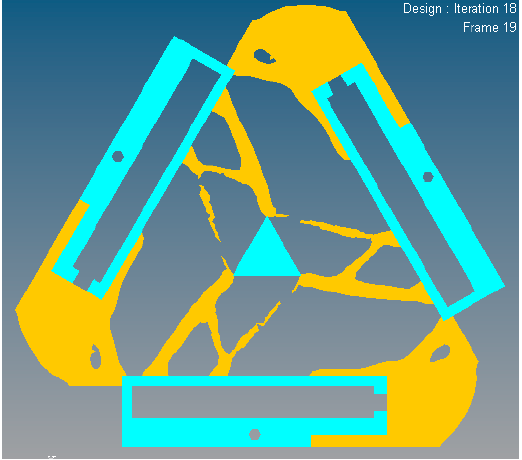
Figure 9. The material distribution of optimized topology mechanism in static load case.